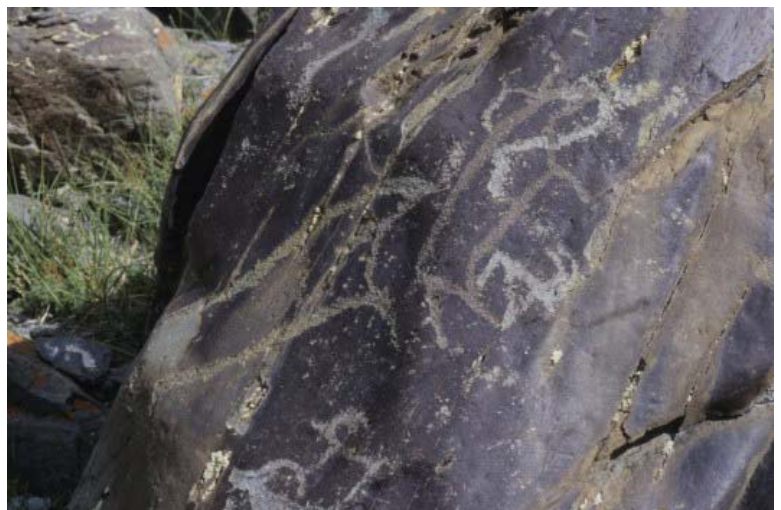
Figure 2. Archaic aurochs overlaid by Iron Age goats. Baga Oigor II.